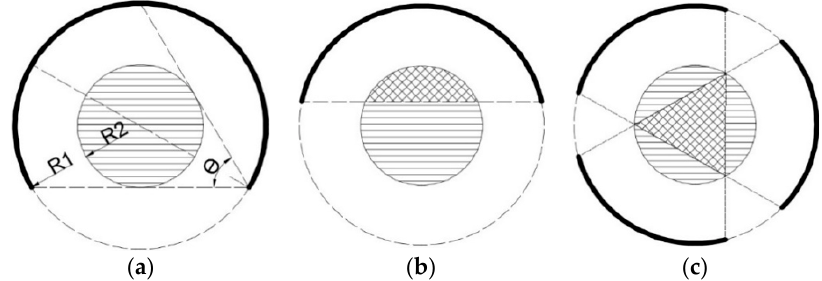
Figure 7. Schematic of the short-scan problem: ( a ) A conventional short-scan of π θ+ allows reconstruction of the whole object; ( b ) A continuous scan of less than π θ+ allows reconstruction of all object points inside the convex hull of the scan; ( c ) A scan of three equally spaced segments of 80° each allows reconstruction of a triangular ROI in the center of the object.